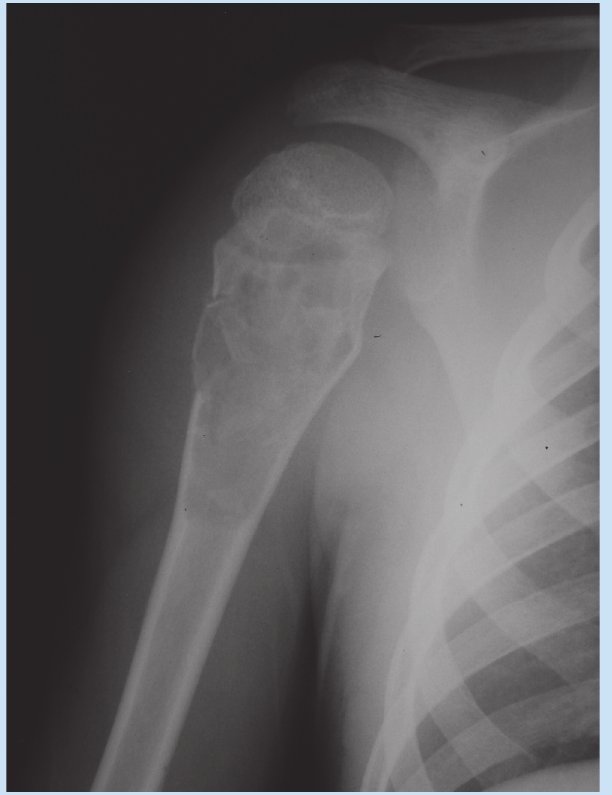
Fig. 1. An expansile medullary, radiolucent lesion in the proximal humeral metaphysis extending to the growth plate is seen. This is the appearance of a simple bone cyst. A common complication is a pathological fracture which is seen to disrupt the cortex laterally in this patient.